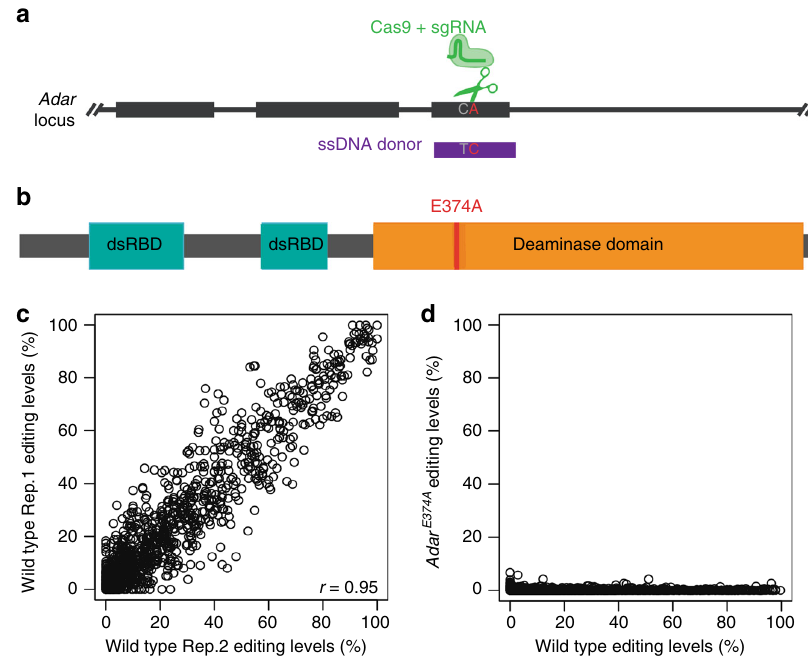
Fig. 1 A point mutation in the ADAR deaminase domain prevents all RNA editing. a Schematic of the DNA mutations made with the Cas9/CRISPR system. The Adar locus is depicted in black, the sgRNA and Cas9 are green, and the DNA donor is purple. The mutations, shown in gray and red, are C1725T (a synonymous change to the PAM region to prevent re-cutting by the CRISPR system) and A1733C (leading to the E374A mutation). The CRISPR target region is on the reverse strand. b Schematic of the domain structure of fl y Adar and the E374A mutation made to the deaminase domain. c Plot of RNA editing levels in two representative control samples. Pearson ’ s correlation is shown. d Plot of RNA editing levels in the wild type versus Adar E374A